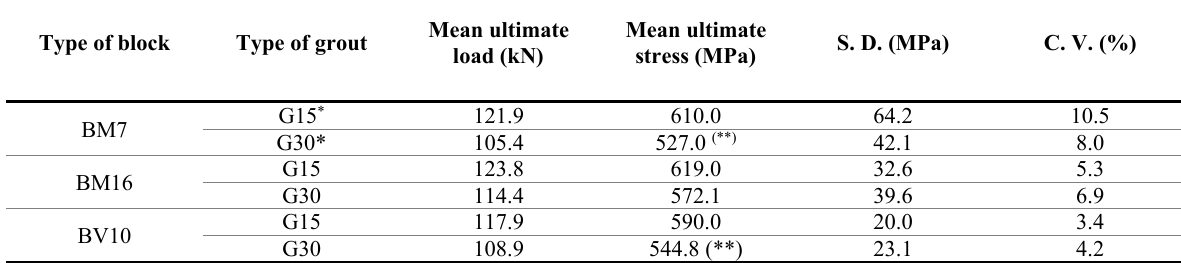
Table 5. Pull-out